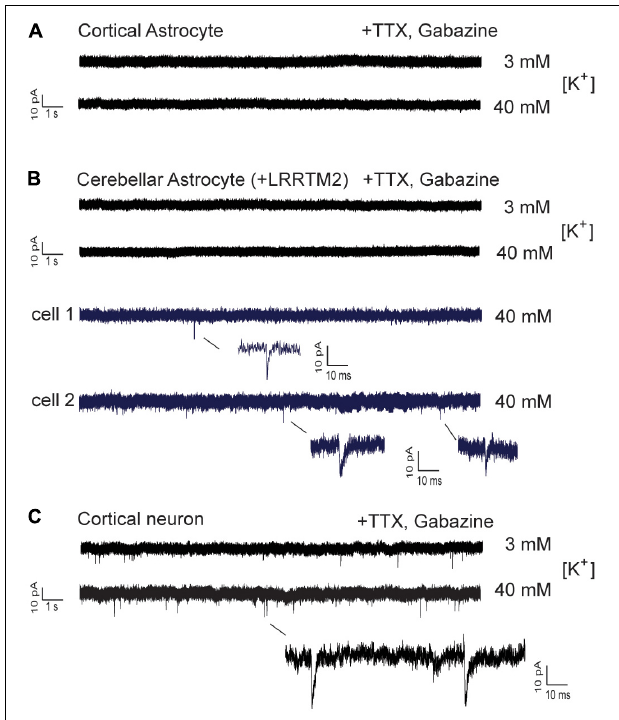
FIGURE 6 | Whole-cell patch-clamp recordings in immature cortical astrocytes and in cerebellar astrocytes expressing LRRTM2. AMPA receptor-mediated miniature EPSCs (AMPA mEPSCs) were pharmacologically isolated by addition of TTX (1 µ M) and gabazine (10 µ M). Holding potential: -60 mV. Extracellular solution contained standard (3 mM) or elevated (40 mM) [K + ] as indicated. (A) Lack of spontaneous AMPA mEPSCs in immature cortical astrocytes contacted by explant axons. n = 16 cells. (B) Lack of spontaneous AMPA mEPSCs in cerebellar astrocytes expressing LRRTM2 and contacted by explant axons. In a total of 16 cells only three individual mEPSC-like events were detected and are shown enlarged (blue). (C) Typical AMPA mEPSCs were routinely recorded in cortical neurons innervated by explant axons. All cells recorded at 12 days in explant co-culture.